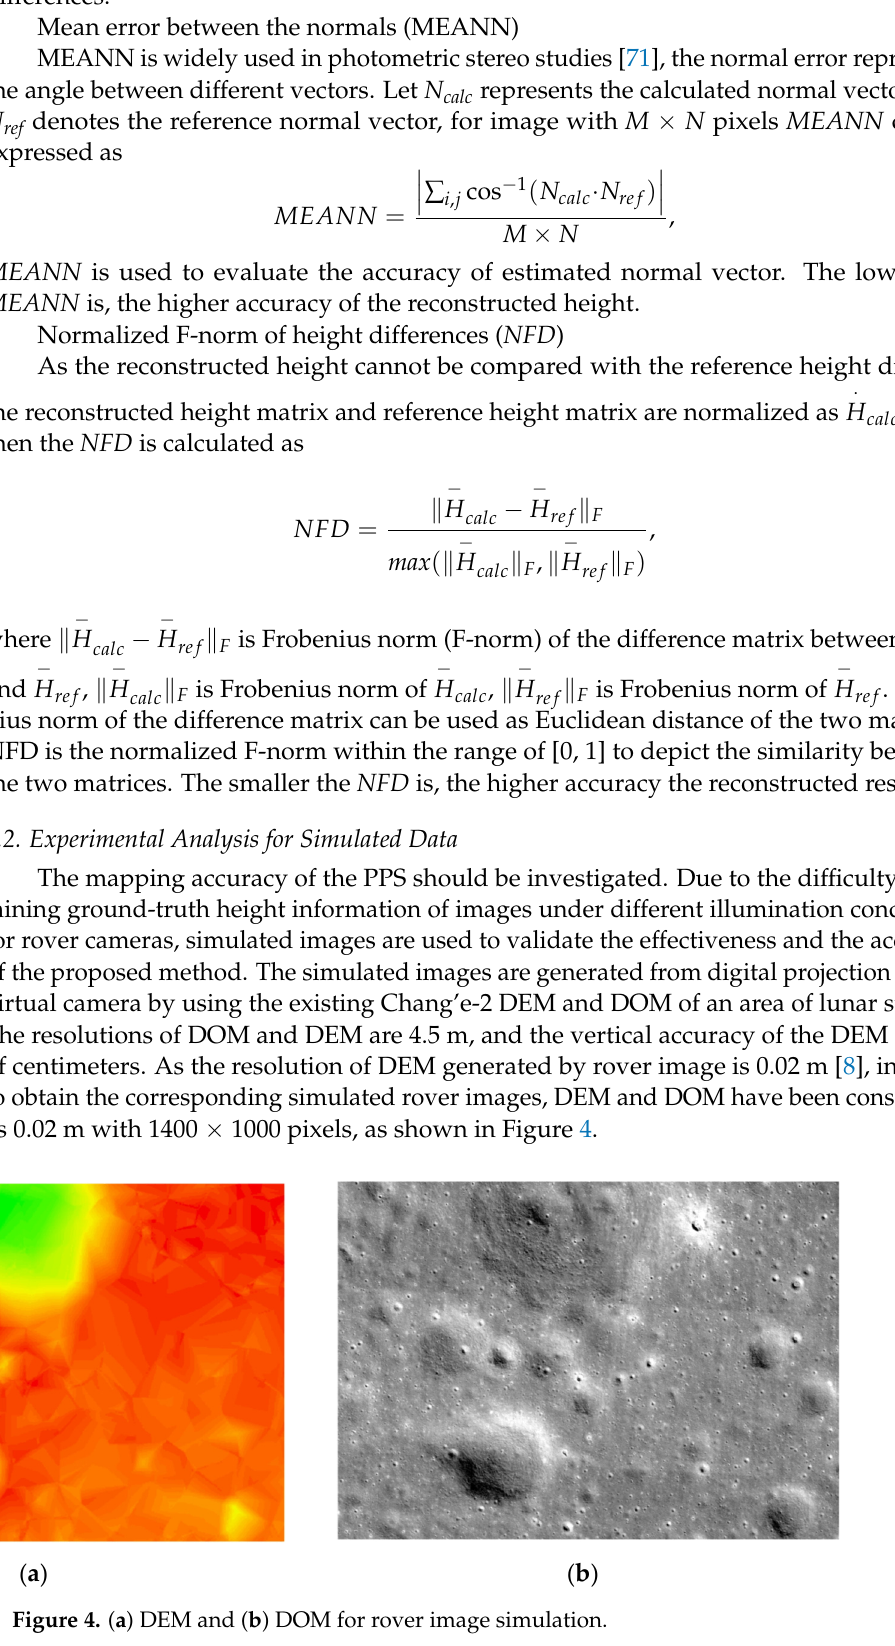
while the exterior orientation parameters of different images are defined differently. Height values from the DEM are used as ground truth. Based on the illumination condi- tions, Chang’e-2 DEM and DOM, ambient lighting, diffuse lighting, and specular light- ing vectors are calculated, respectively, and Lommel – Seeliger model is used to derive the simulated images. Figure 5 shows three simulated images under different illumina- tion conditions. Table 1 lists illumination conditions of the simulated images. There are tens of small craters in the image, and a larger crater is clear on the right side. As the field of view (FOV) of the camera is limited, the craters show different scales, specifically the crater in the red rectangular of Figure 5a corresponds to the marked crater in Figure 5c, other craters in the distance have been compressed due to the principle of the pin-hole model. In order to verify the method efficiently, there are no shadows in the simulated images. Figure 5. Simulated images under different lighting conditions ( a ) simulate image of solar azimuth angle 90°and elevation angle 55° ( b ) simulate image of solar azimuth angle 90°and elevation angle 60° ( c ) simulate image of solar azimuth angle 90°and elevation angle 65° ( d ).